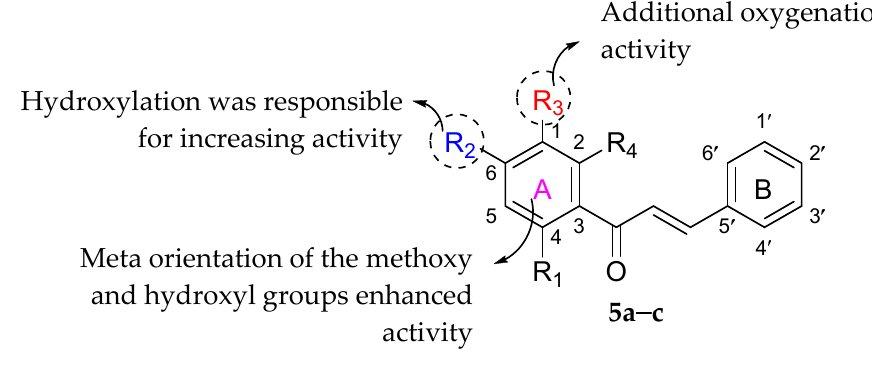
20 of 44 Figure 17. Chemical structures of Balsacone R and Balsacone Q, with the SAR of balsacones for their anti-MRSA activity [83]. Table 10. Anti-MRSA activities of flavonoids isolated from Kenyan plants.